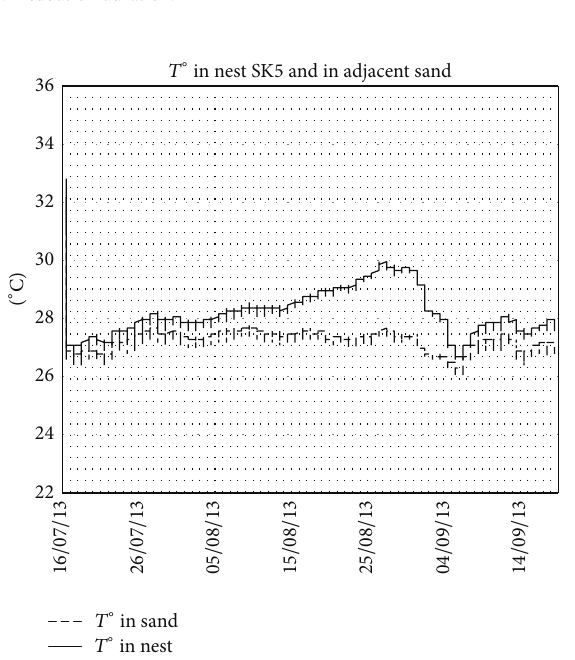
Figure 4: Temperatures in nest SK5 (majority of eggs with embryos died in late phase of development) and in adjacent sand. Note the lowerdifferencebetweeninsideandoutsideofthenestafterembryos died on